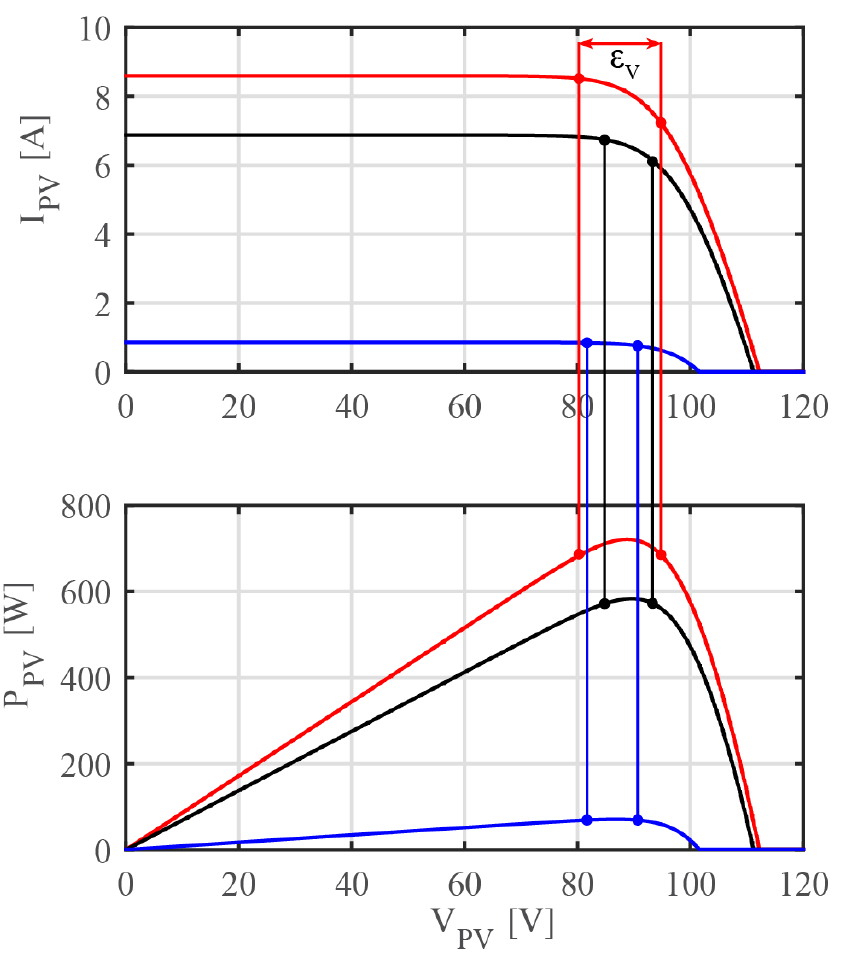
Figure 8. Error estimation on PV module I–V curve and P–V curve at different irradiation val- ues @Tref.